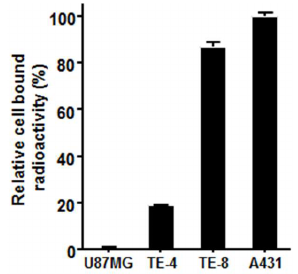
Figure 2. In vitro cell binding assay of 64 Cu-PCTA-cetuximab. A431 and U87-MG cells were used as positive and negative control, respectively. Data presented as the percentage (%) of relative cell-bound radioactivity to A431 cells.